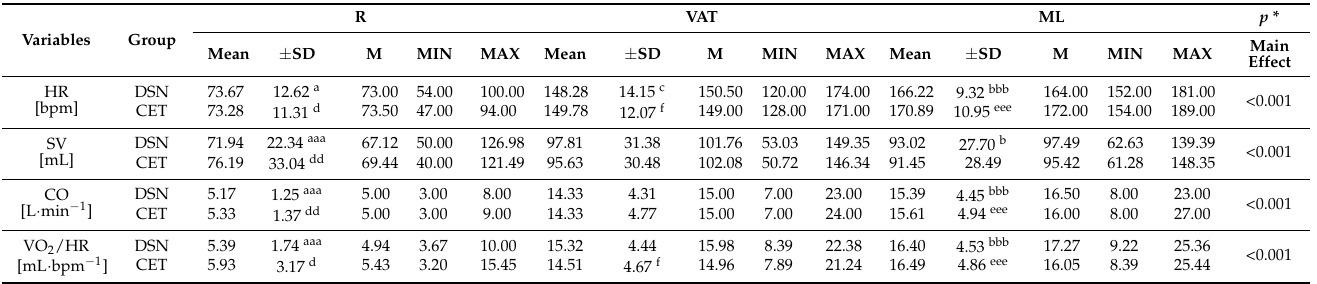
Table 3. Statistical comparisons of the cardiovascular values obtained during DSN and CET (n =